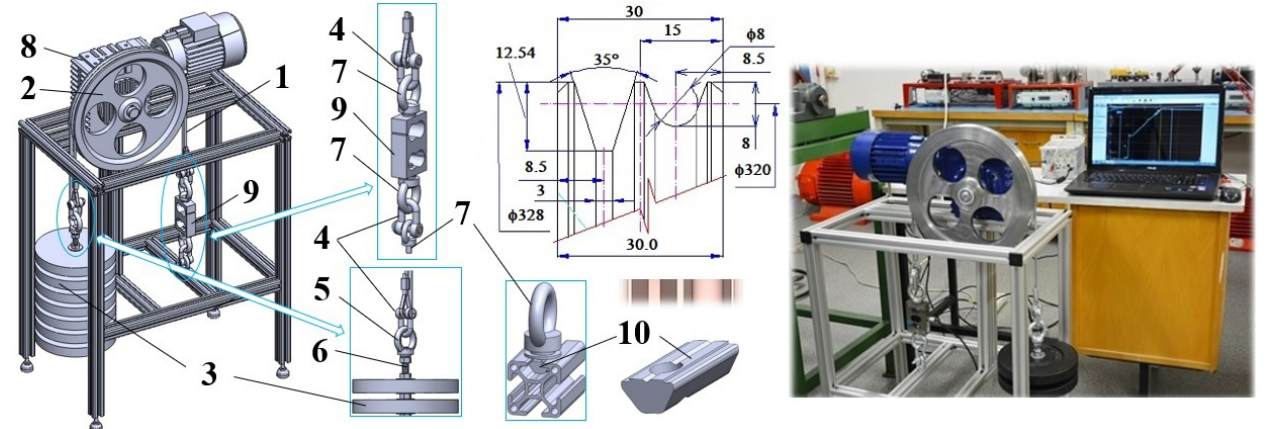
Figure 7. Laboratory equipment used to measure the pulling force on the advancing side of the cable on the pulley.